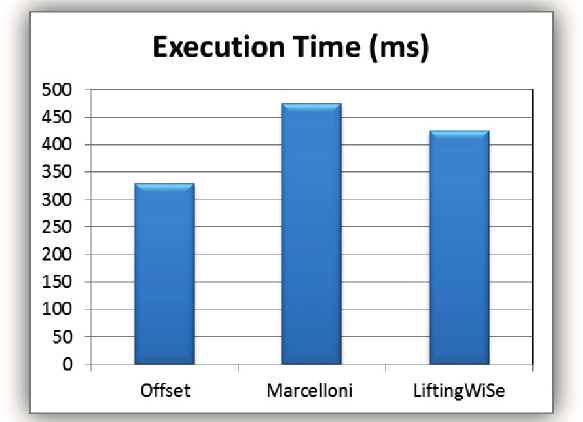
Figure 14. Computational time complexity